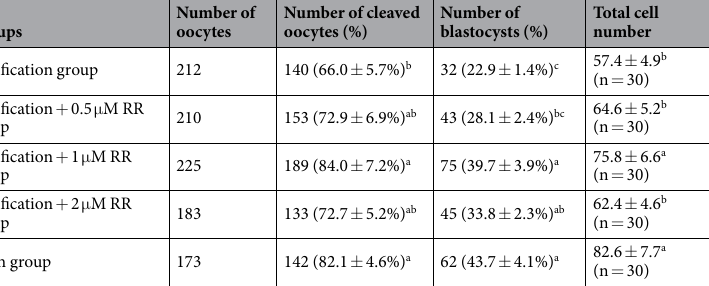
Table 5. Effect of RR treatment on the development potential of vitrified bovine oocytes after PA. a,b,c Values with different superscripts differ significantly within the same column ( P < 0.05).